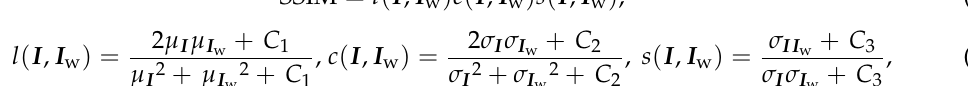
Figure 4. Host images and the original watermark: ( a ) Lena; ( b ) Barbara; ( c ) Boat; ( d ) Airplane; ( e ) Peppers; ( f ) Baboon; ( g ) Clock; ( h ) Original